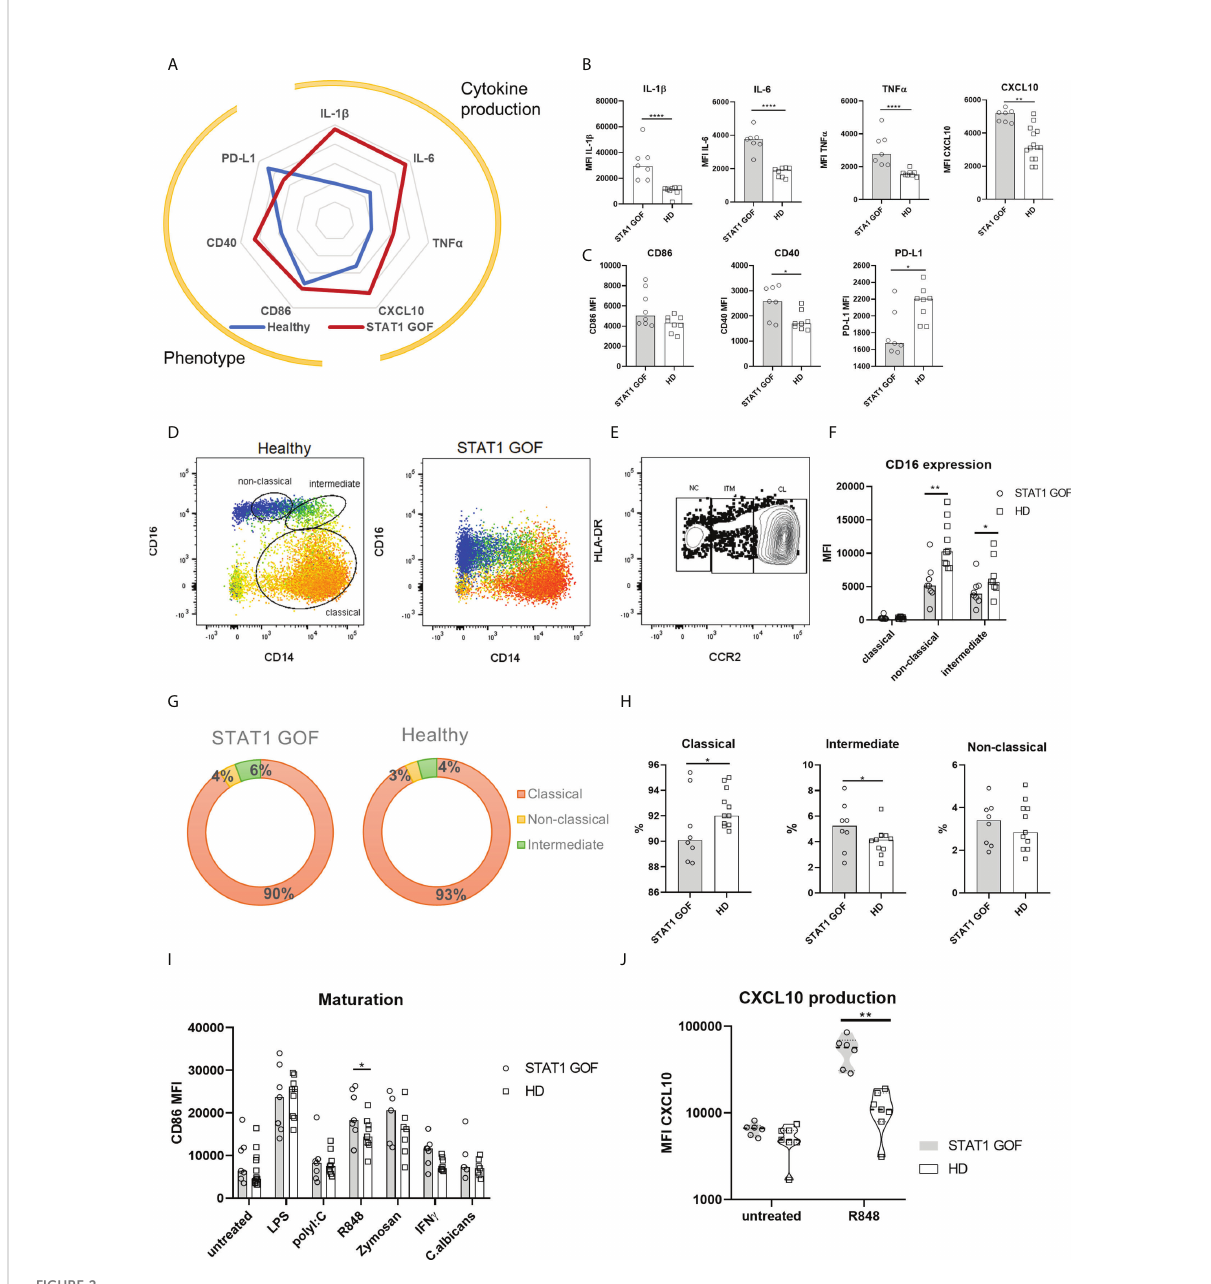
FIGURE 2 Monocyte characteristics. (A) Radar graph of STAT1 GOF (n = 7) and HDs ’ (n = 8) monocyte phenotype and basal cytokine production (B) Cytokine production of STAT1 GOF (n = 7) and HDs ’ (n = 8) monocytes detected by fl ow cytometry (C) Phenotype of STAT1 GOF (n = 7) and HDs ’ (n = 8) monocytes detected by fl ow cytometry (D) Representative dot plot of monocyte subset determination (E) Representative dot plot of monocyte subset determination utilizing CCR2 expression (F) CD16 expression on monocyte subsets surface of STAT1 GOF (n = 7) and HDs (n=8) detected by fl ow cytometry (G) Distribution of monocyte subsets in STAT1 GOF (n = 7) and HDs (n = 8) (H) Quanti fi cation of monocyte subsets in STAT1 GOF (n = 7) and HDs (n = 8) (I) CD86 expression on monocyte surface upon stimulation of various TLR ligands for 24hours in STAT1 GOF (n=7) and HDs (n=9) detected by fl ow cytometry (J) CXCL10 production by monocytes upon R848 (1ug/ml) stimulation in STAT1 GOF (n = 7) and HDs (n=8) detected by fl ow cytometry HD - healthy donors. Values are standardized and expressed as median values. Statistical analyses were performed using paired t-tests. Values of p<0.05 (*), p<0.01 (**), and p<0.0001 (****) were considered statistically signi fi